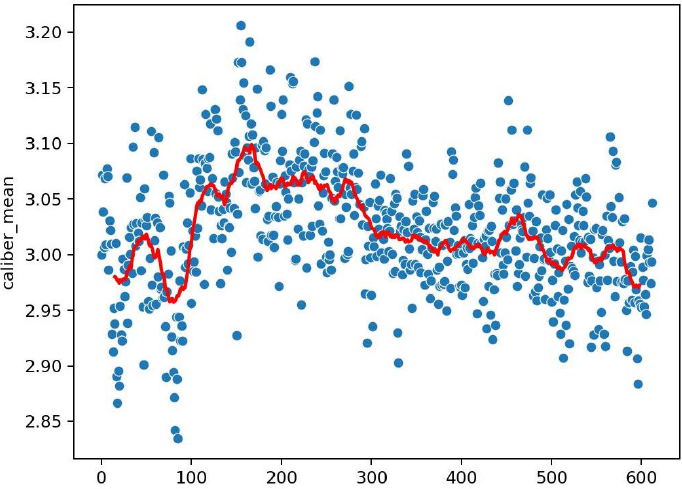
Figure 9. Dot representation as for Figure 3 but with respect to the information of Figure